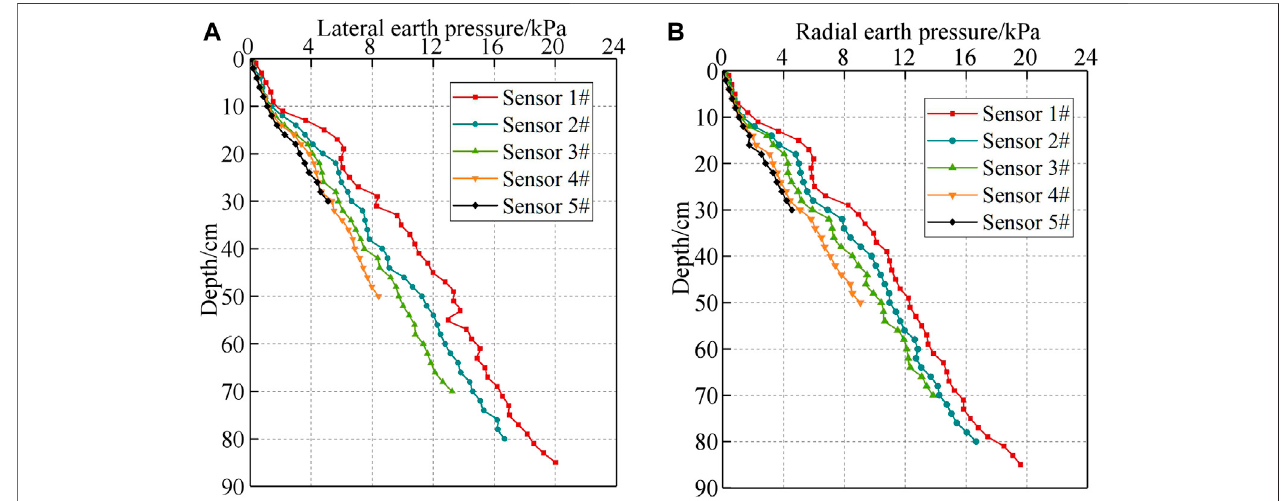
FIGURE 10 | Radial earth pressure curves at the pile surface with depth: (A) TP1, (B) TP2.